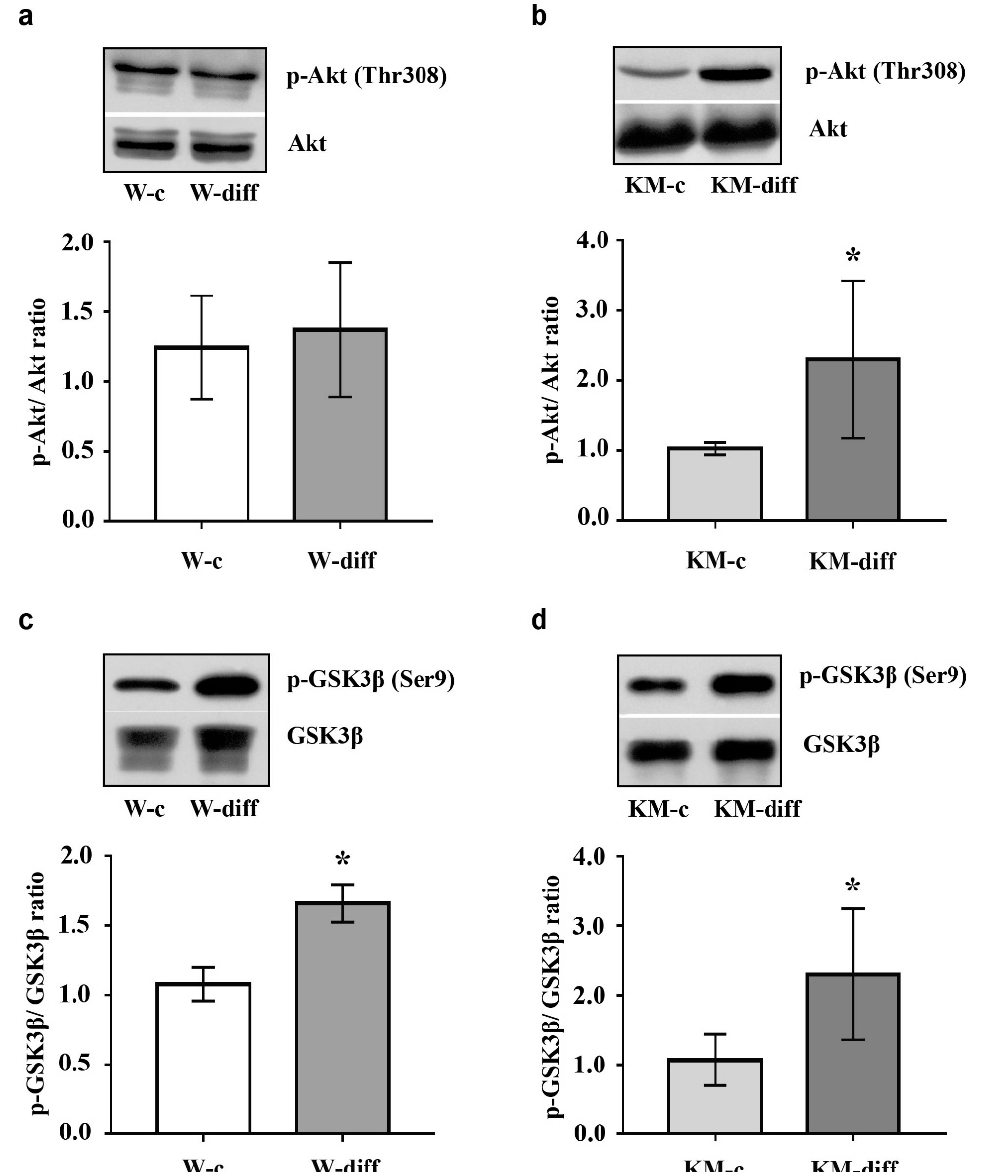
Figure 6. Western blot analysis of protein kinase B (Akt) and glycogen synthase kinase 3 beta (GSK3β) phosphorylation in KM and Wistar NPC. ( a , b ) Expression of phosphorylated Akt (p-Akt) in cultured NPC of Wistar ( a ) and KM ( b ) rat embryos in control groups (W-c, KM-c) and after stimulated glutamatergic differentiation (W-diff, KM-diff). ( c , d ) p-GSK3β expression in stimulated Wistar ( c ) and KM ( d ) NPC after glutamatergic differentiation (W-diff, KM-diff) as compared with corresponding controls (W-c, KM-c). Expression of p-Akt demonstrated significant increase only in stimulated KM NPC culture, while p-GSK3β was elevated in both cell cultures after differentiation. Data are calculated from three independent experiments. Results are presented as mean ± SD. * p < 0.05.